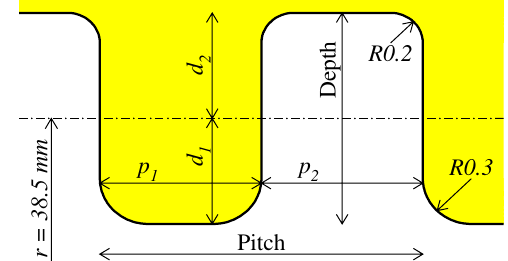
FIG. 2. Definitions of pitch and depth in this paper. The solid line indicates a grooved surface of the outer conductor (yellow area) of the coaxial line. The dash-dotted line indicates the radial position of the inner surface of the ungrooved outer conductor: r ¼ 38 : 5 mm . We assume that p d ¼ depth = 2 in this groove design. 2